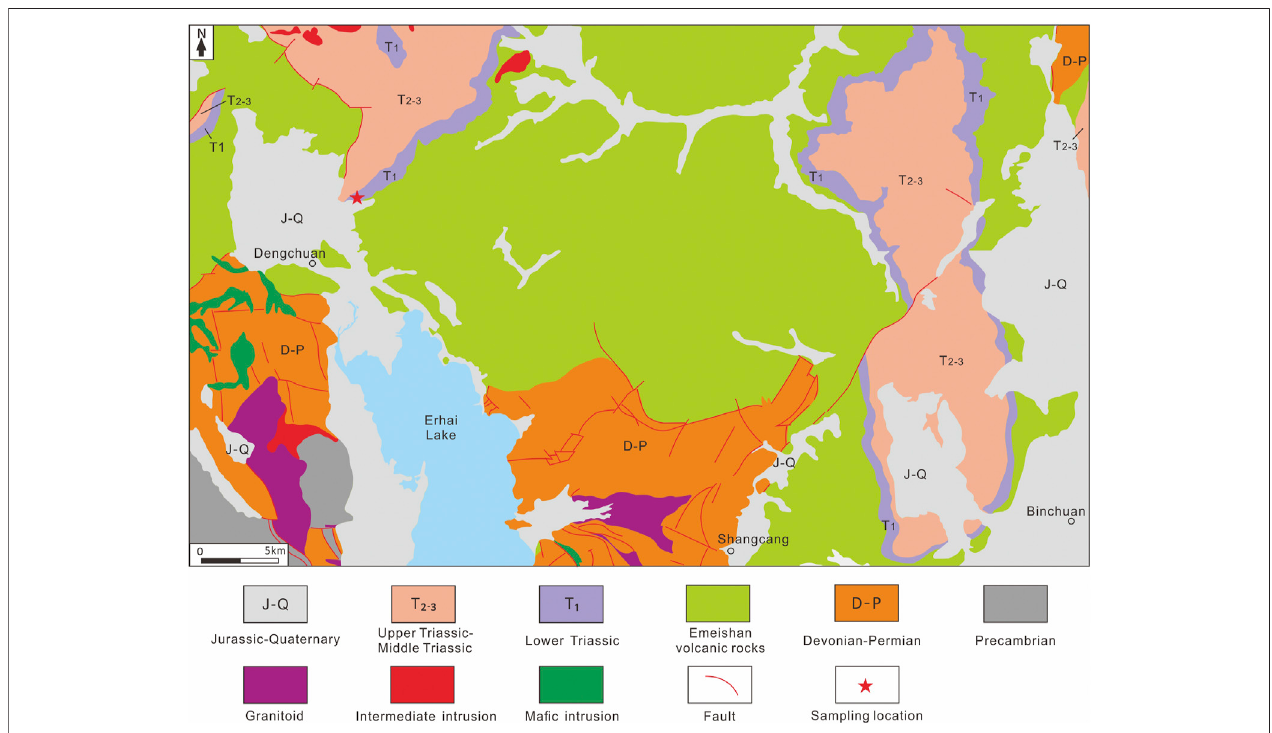
FIGURE 2 | Geological map of the Dengchuan area (modi fi ed after Yunnan Geologic Bureau, 1966, Yunnan Geologic Bureau, 1973).